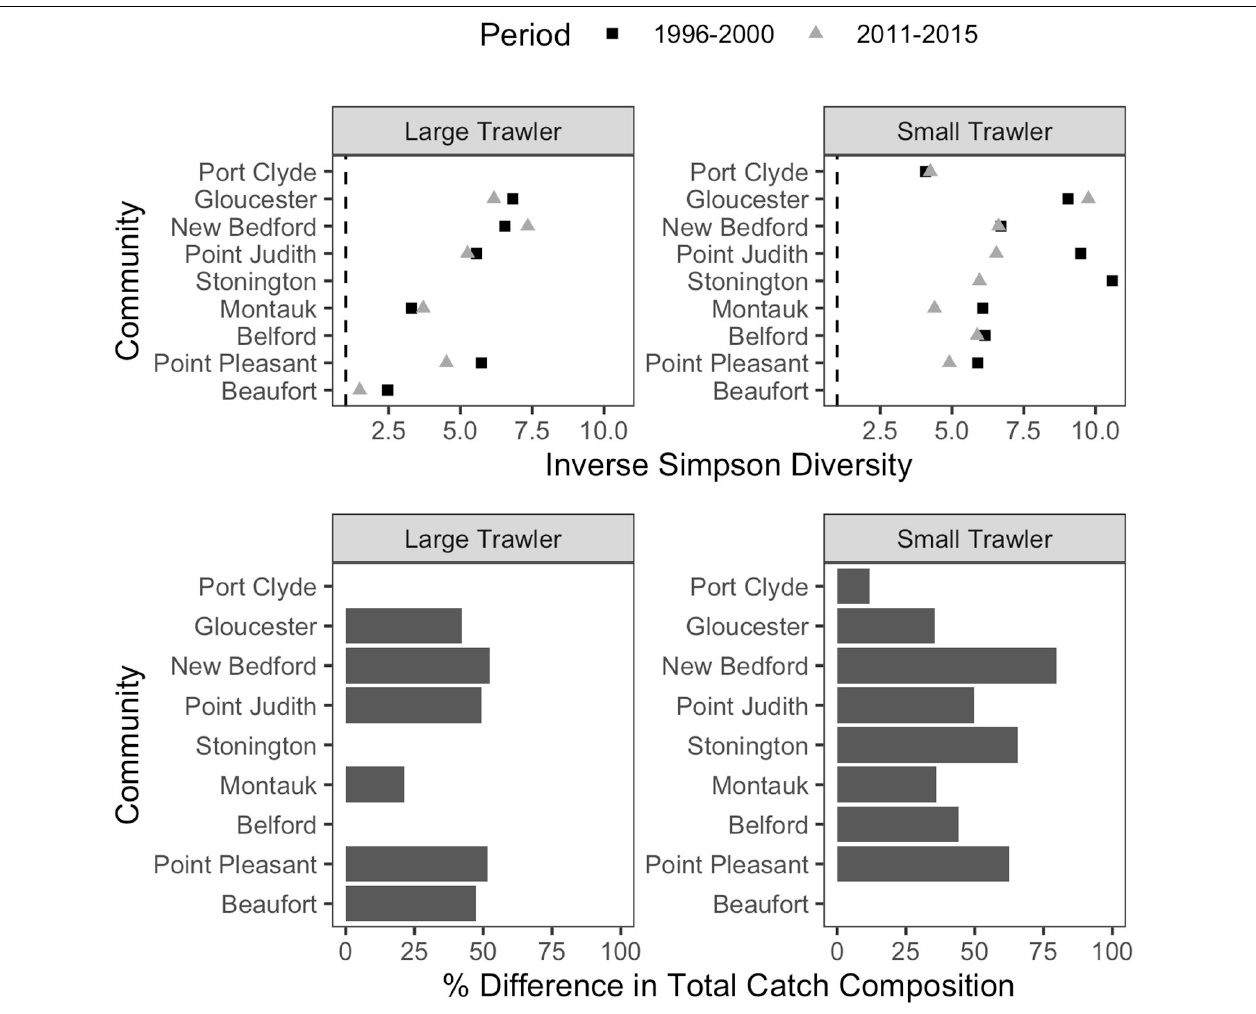
FIGURE 8 | T rends in catch composition in focal communities. (Top) Inverse Simpson Diversity in the baseline (1996–2000; dark gray square) and recent (2011–2015; light gray triangle) for each community. A value of 1 would mean only one species was caught, and higher values represent more species caught more evenly. (Bottom) the percent difference in total catch composition between the baseline (1996–2000) and recent period (2011–2015) is calculated as the % dissimilarity in the proportion of the total catch represented by each species. A dissimilarity of 100% would indicate a catch composition in the recent period that was completely distinct from the baseline time period. A value of 0% would indicate the mix of species caught in the recent period is identical to that in the baseline time